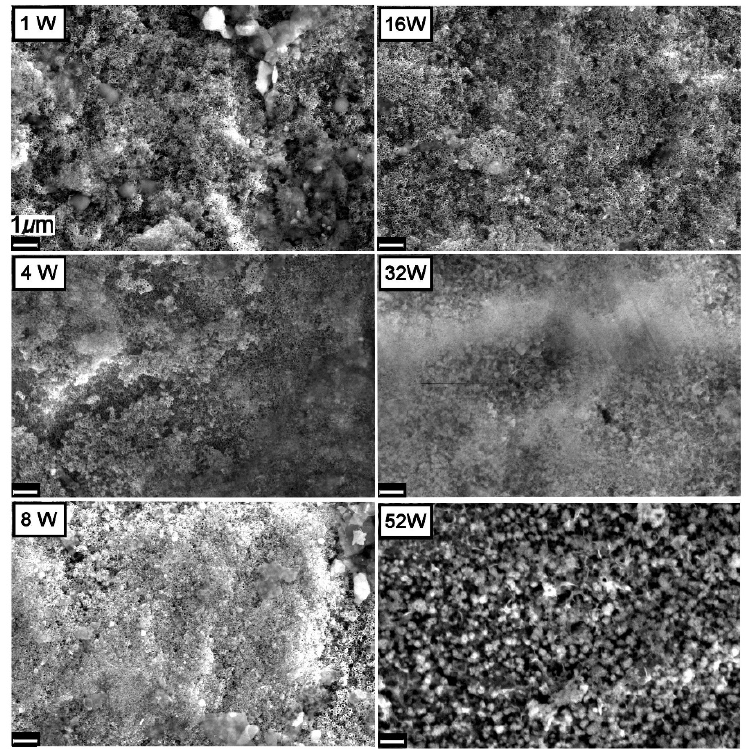
Figure 7. Changes observed on the surface of the TiO 2 NT-S sample when exposed to synthetic greywater under atmospheric conditions.